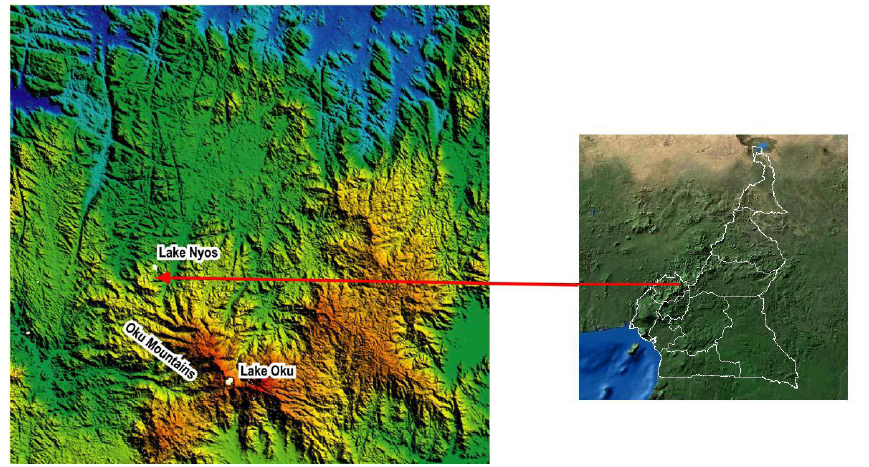
Figure 1: Location of the Lake Nyos